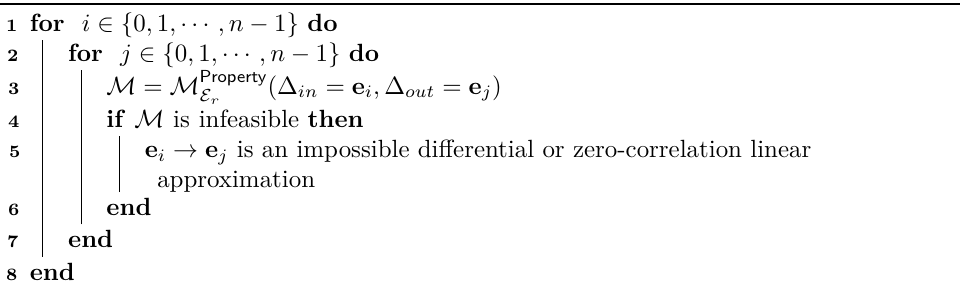
Algorithm 3: Search for impossible differential or zero-correlation linear approx-